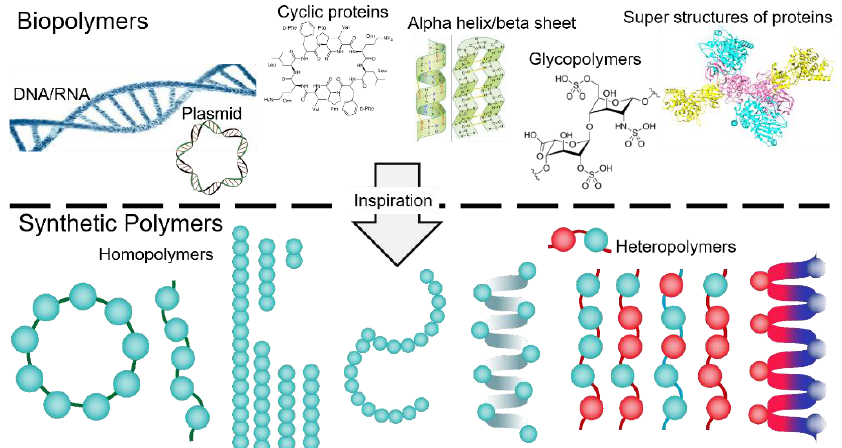
Figure 1. Schematic view of diverse biopolymers in cells, and their resemblance to chemically synthesized polymers that have been shown broad utilities in biomedical research. During the synthetic process of homo ad heteropolymers, optimizing the sequence, length and shape (linear vs. circular), backbone flexibility, stereochemistry, and homogeneity are crucially difficult to manage.